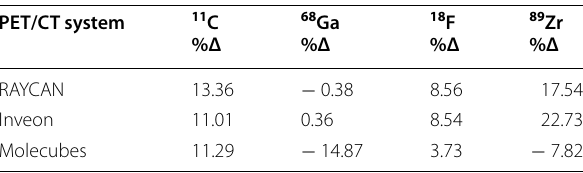
Table 7 Percentage difference (%Δ) of the mean activity in the uniform compartment of the phantom compared to the reference activity measured at scan start time PET/CT